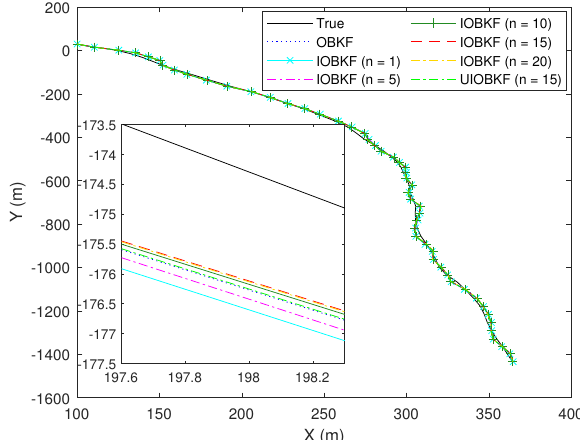
Figure 3. True and estimated trajectories.